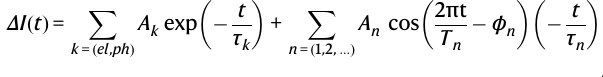
supported on a monocrystalline silicon substrate and the silicon nanotip arrays. c , d Simulatedthermaldistributioninthetimedomainofthetwosupportedforms of the optomechanical metasurface. e , f The simulated geometric strain of the metasurface under the same